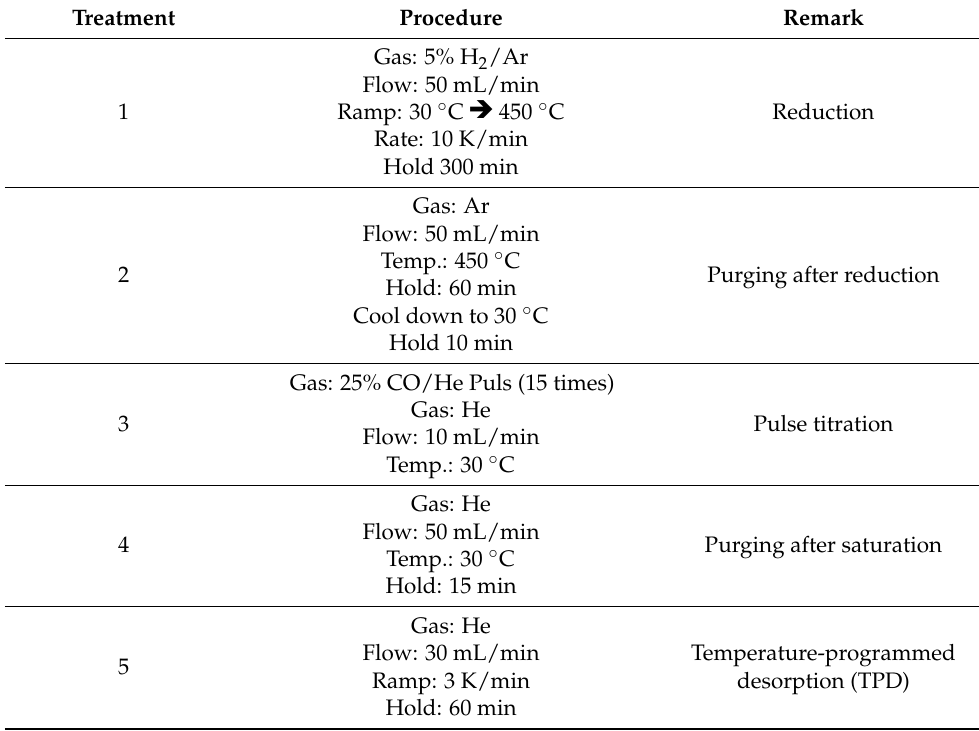
Table 7. Treatment Procedures for the CO-TPD measurements.